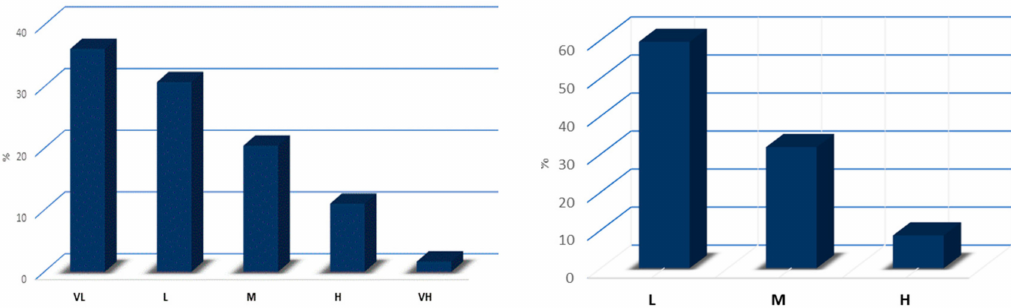
Figure 13. Histograms of flood susceptibility classes for five classes ( left ) and three classes ( right